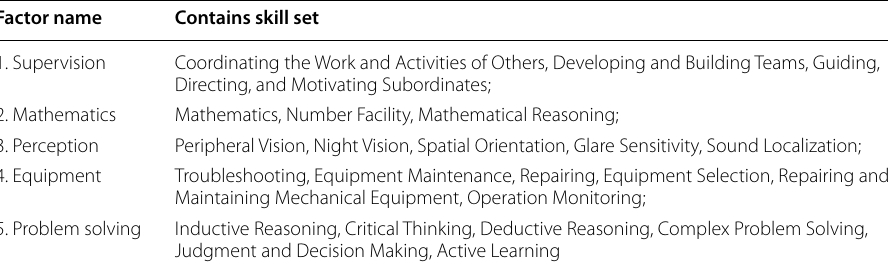
Table 7 FA O*NET